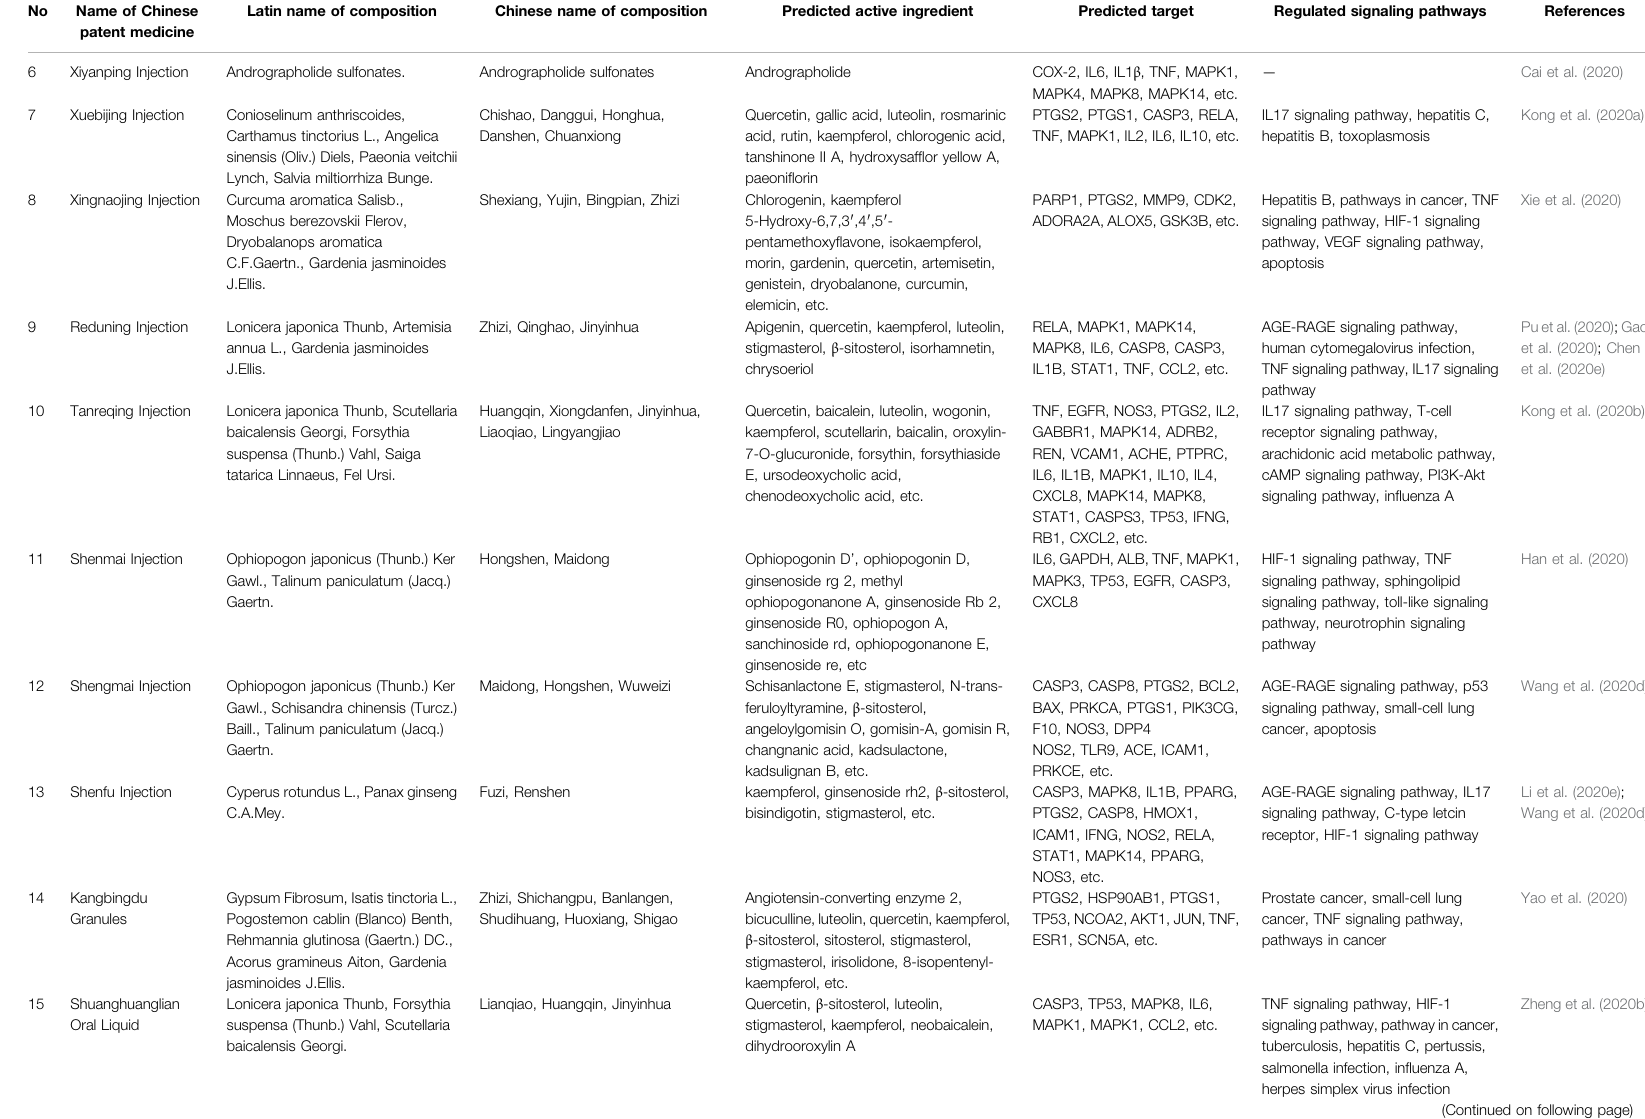
TABLE 3 | ( Continued ) Summary of potential action mechanisms of CPMs for